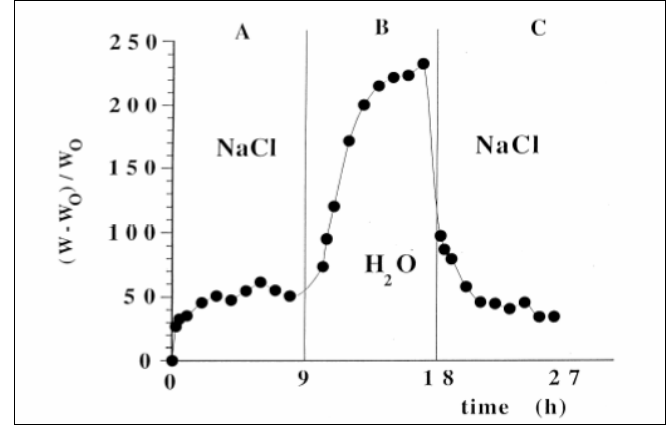
Figure 5. Effect of ionic strength on solvent uptake by the crosslinked polysaccharide ( r =0.5), determined as a function of time at 37 °C. (A) in 0.9% (w/v) NaCl solution, (B) in distilled water and (C) in 0.9% (w/v)